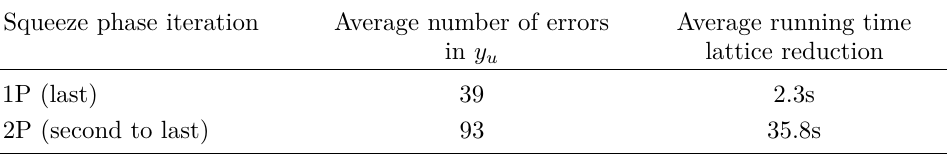
Table 3: Results of injecting faults in DeterministicSample